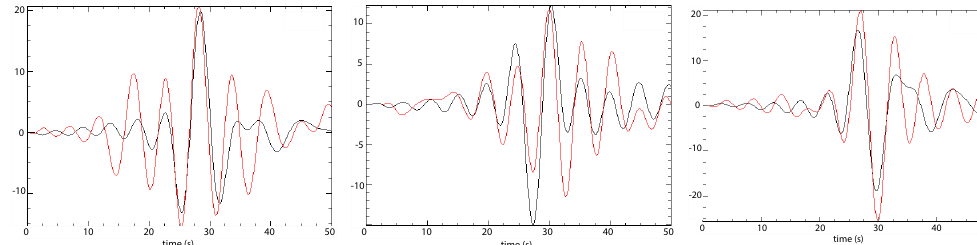
Figure 4. Comparison between the observed (black line) and synthetic (red line) time histories of peak ground acceleration (PGA) (cm/s 2 ). The three components N, E and Z are